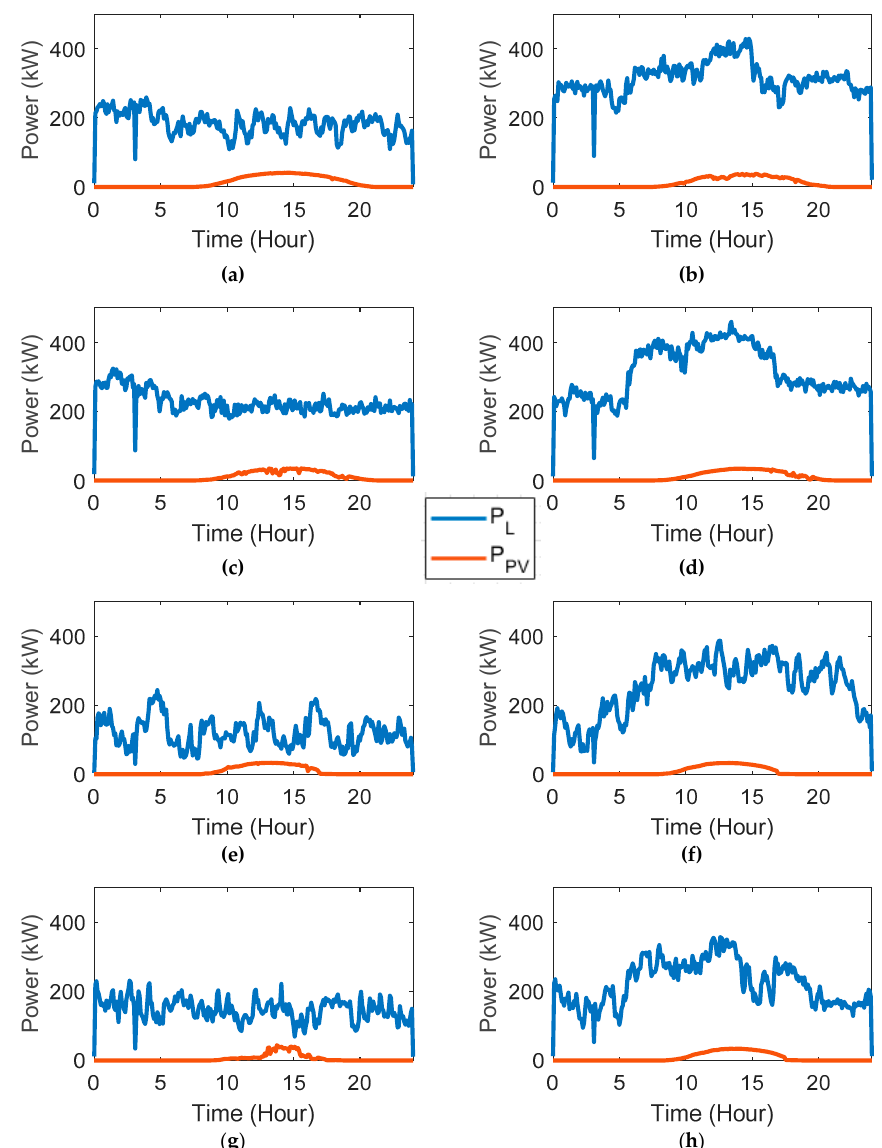
Figure 3. Daily load and photovoltaic generation profiles. Industry A. ( a ) Weekend-May 6; ( b ) Labor Day-May 4; ( c ) Weekend-August 6; ( d ) Labor Day-August 7; ( e ) Weekend-November 5; ( f ) Labor Day-November 6; ( g ) Weekend-February 4; ( h ) Labor Day-February 6.